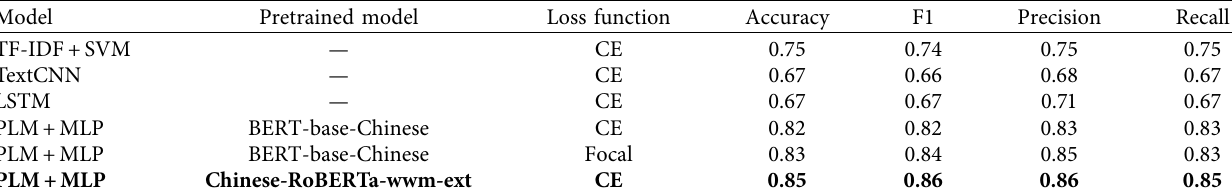
Table 5: Comparative experimental